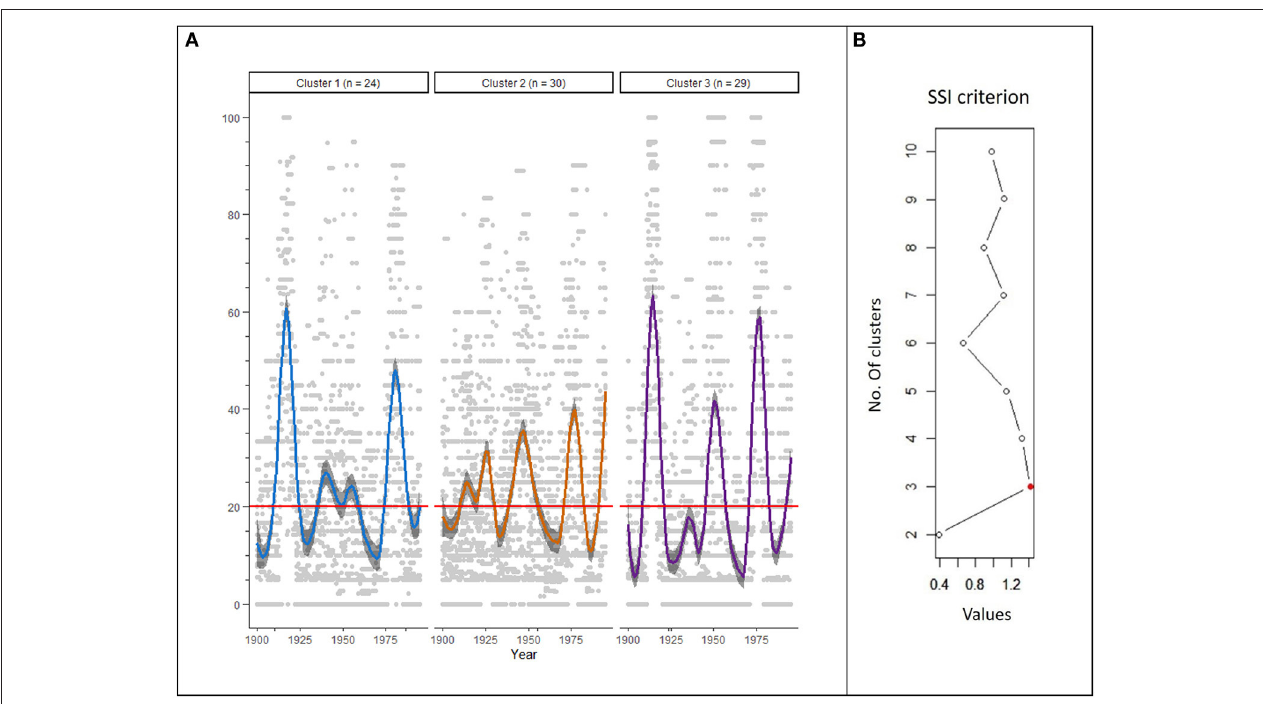
FIGURE 2 | (A) Annual percentage of affected trees in the studied stands for the three clusters identified by k-means clustering. The curves are a LOESS (locally estimated scatterplot smoothing) of the annual percentage of trees affected per year, using a smoothing of 10%. The gray band around the curves corresponds to a 95% confidence interval. The red line corresponds to a percentage of affected trees of 20%. (B) Values of the SSI criterion according to the number of clusters. The red dot indicates the optimal SSI criterion for the partition of